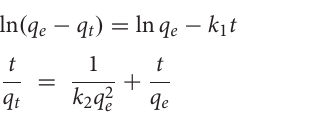
model, smaller R 2 values were obtained. The maximum adsorption capacity values of Cr(VI) from the Langmuir isotherm models were 5.263 mg · g − 1 for TOCNF-PABS and 0.518 mg · g − 1 for